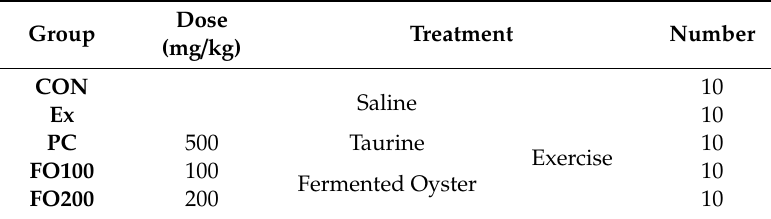
Table 2. In vivo experimental